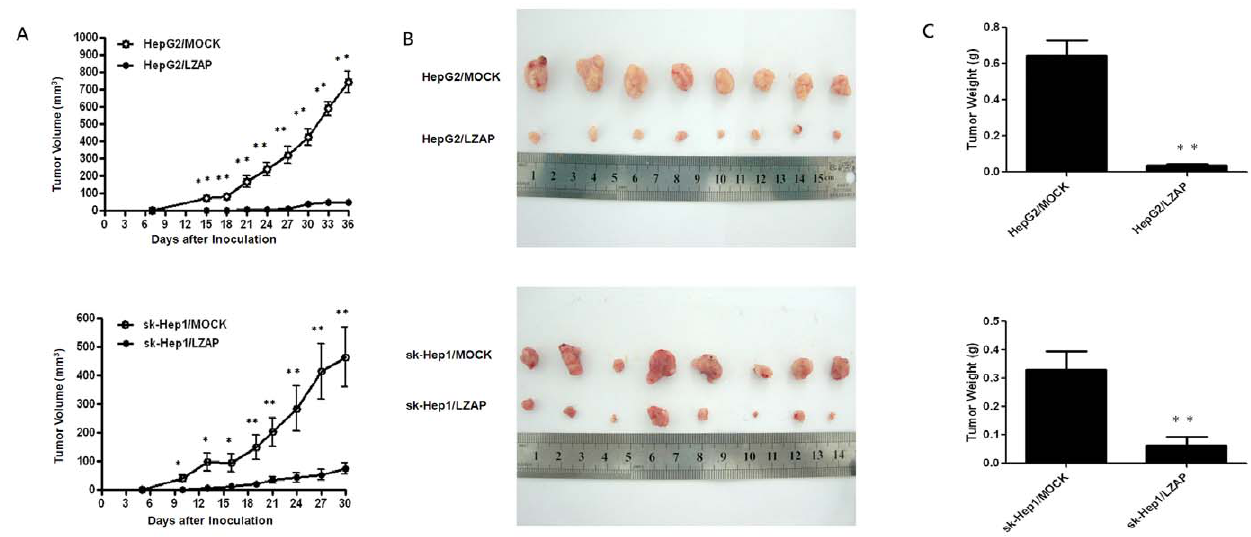
Figure 7. LZAP suppresses the tumorigenicity of HCC in vivo. HepG2 or sk-Hep1 cells infected with Ad-control and Ad-LZAP were injected into nude mice, as described in the Materials and Methods section. The tumor volumes were measured every 3 days. At the end of the experiment, the animals were sacrificed and the tumors were excised for volume and weight measurement. ( A ) The tumor growth curves for each group. The tumor growth rate was reduced in the tumors that overexpressed LZAP. ( B ) Photographs of dissected tumors from the nude mice. The final tumor volumes were smaller in the HepG2-LZAP and sk-Hep1-LZAP groups than in the control group. ( C ) The tumor weights of each group. The final tumor weights were reduced in the tumors that overexpressed LZAP. The data are presented as mean 6 SD. *p , 0.05 versus Ad-control; ** , 0.01 versus Ad- control.